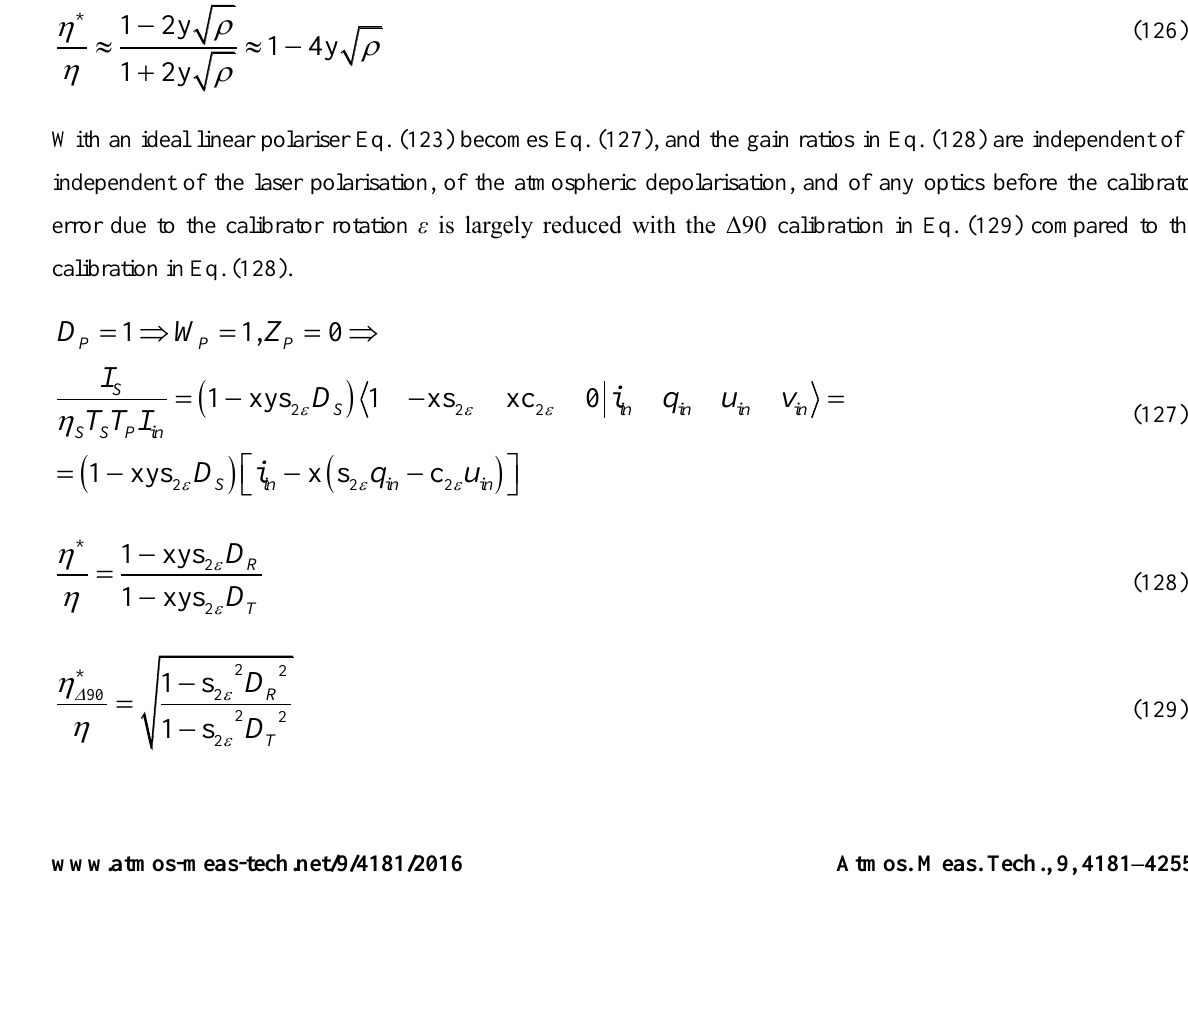
Using Eq. (S.10.10.8) for the extinction ratio ρ of the real linear polariser, we get the approximation Eq. (126) for the gain ratios depending on ρ , with which we can estimate the error of the gain ratio if we use a real polariser with extinction ratio ρ for the measurements but assume an ideal polariser as a calibrator in the correction equations. Equation (126) with ρ = 10 -5 and ρ = 10 -4 , for example, gives relative errors of the gain ratios of about 1.3 and 8 %, respectively.